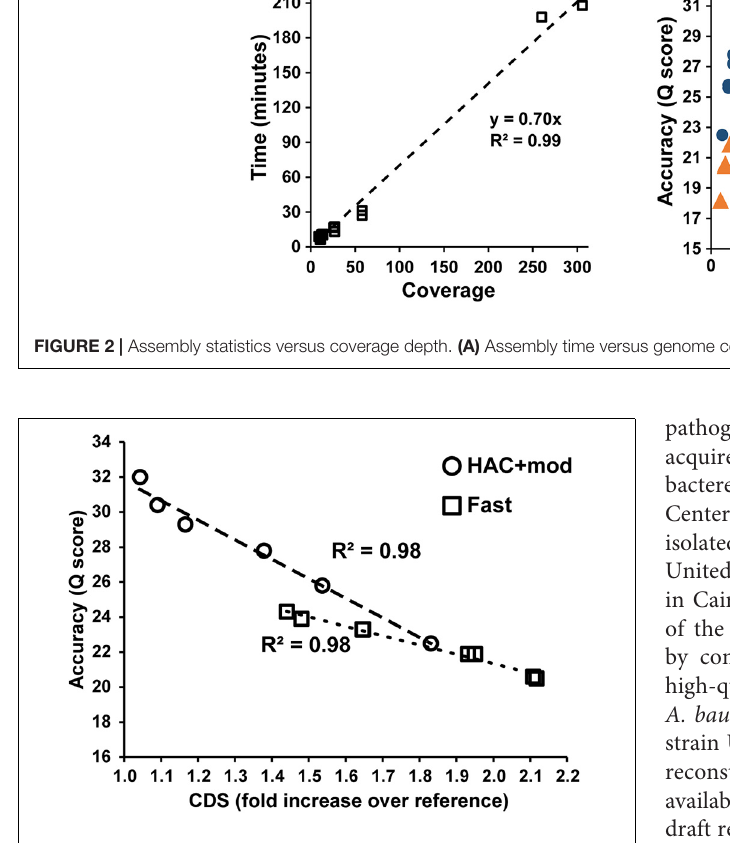
FIGURE 3 | Assembly accuracy versus the number of coding DNA sequences